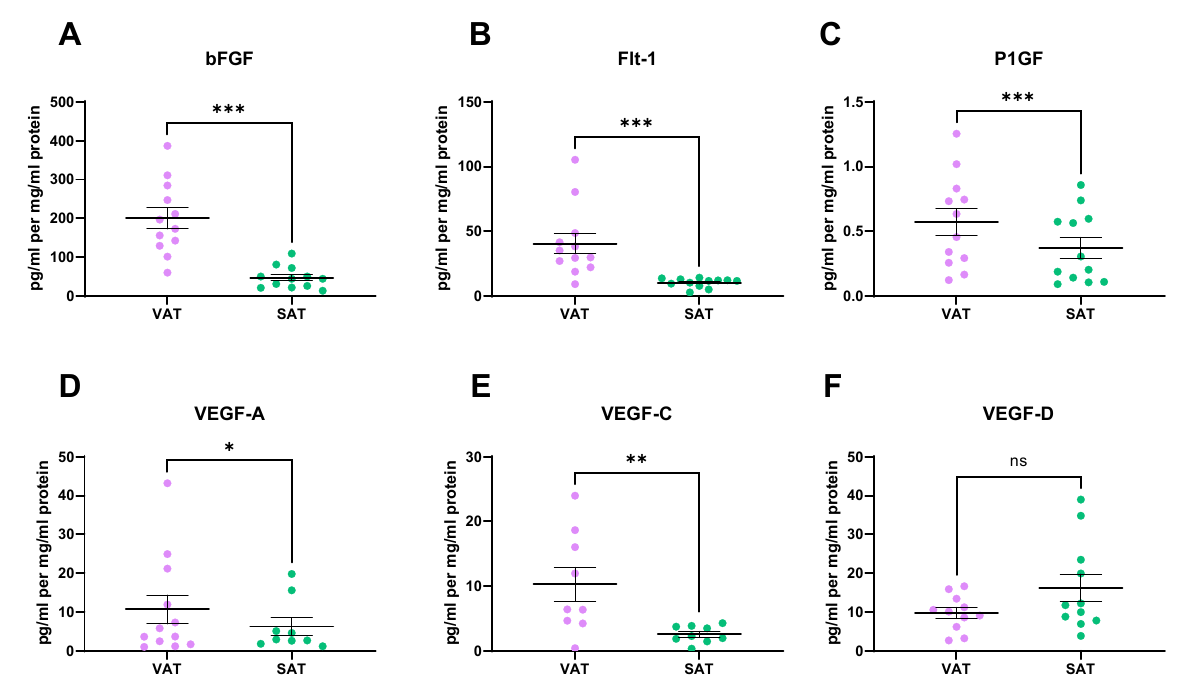
Figure 4. Angiogenic factors are secreted at higher levels from visceral adipose tissue (VAT), when compared to subcutaneous adipose tissue (SAT). Significantly higher levels of ( A ) bFGF, ( B ) Flt-1, ( C ) P1GF, ( D ) VEGF-A and ( E ) VEGF-C are secreted from VAT, when compared to SAT. ( F ) VEGF-D is showing a trend towards elevated levels in SAT compared to VAT. Statistical analysis was performed using a Wilcoxon signed rank test. All data expressed as mean ± SEM. n = 12 for bFGF, Flt-1 and P1GF, n = 11 paired samples for VEGF-D, n = 9 for VEGF-A and VEGF-C. *** p < 0.001, ** p < 0.01, * p < 0.05, ns = non-significant.